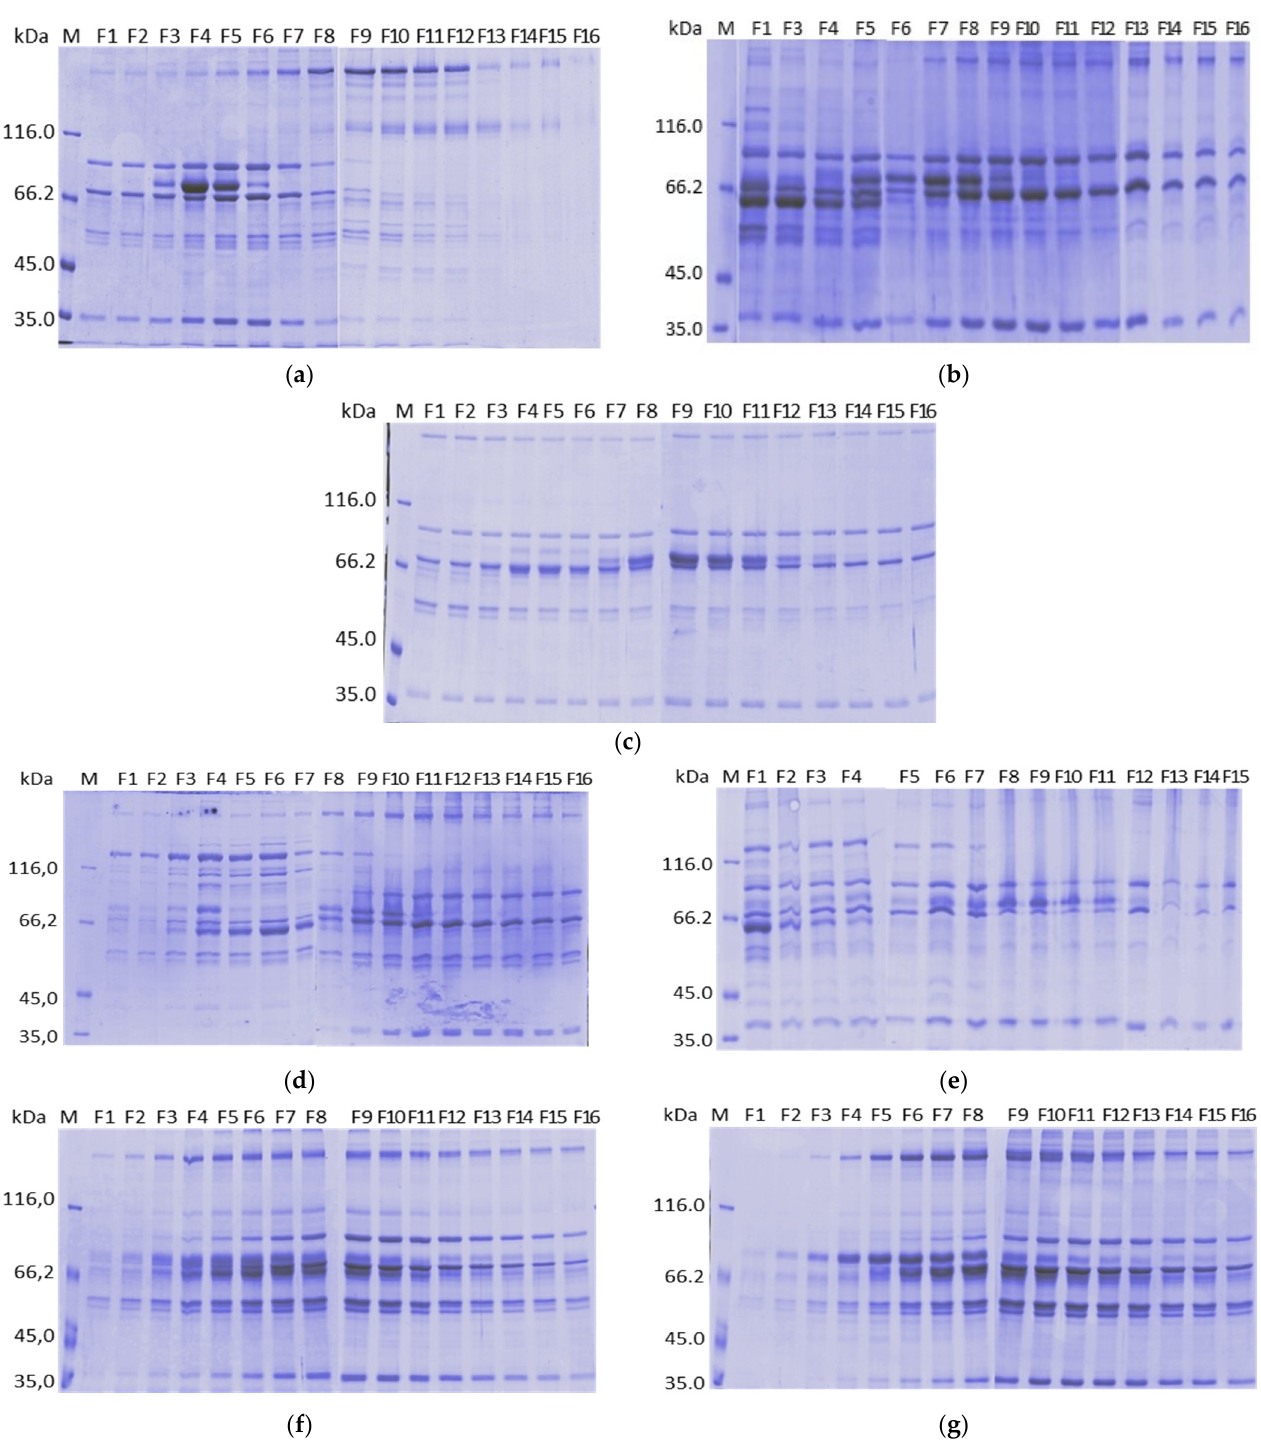
Figure 3. SDS-PAGE (7.5%) analysis under reducing conditions of purification of plasma on: ( a ) Q Sepharose FF with 5 to 100 mM linear CaCl 2 gradient and citrate buffer; ( b ) Fractogel EMD TMAE with 5 to 50 mM linear CaCl 2 gradient and citrate buffer; ( c ) ANX Sepharose FF with 5 to 25 mM linear CaCl 2 gradient using citrate buffer; ( d ) DEAE Sepharose FF with 5 to 50 mM linear CaCl 2 gradient and citrate buffer; ( e ) Fractogel EMD DEAE with 5 to 50 mM linear CaCl 2 gradient and citrate buffer; ( f ) ANX Sepharose FF with 5 to 25 mM linear CaCl 2 gradient and Bis-tris buffer; and ( g ) ANX Sepharose FF with 5 to 25 mM linear CaCl 2 gradient and MES buffer. Lanes: M molecular mass marker; F1 to F16 fractions collected on linear CaCl 2